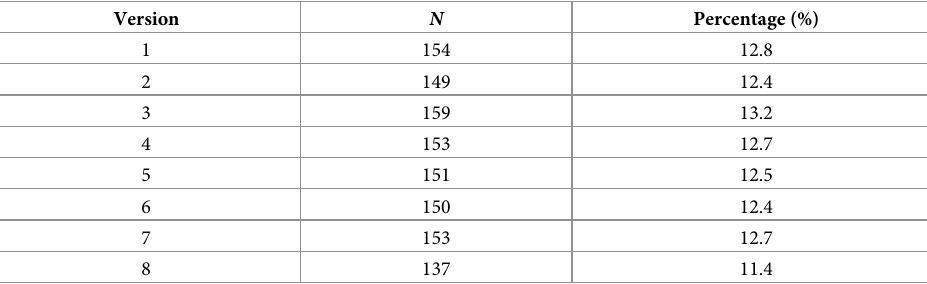
Table 2. Distribution of the different questionnaire